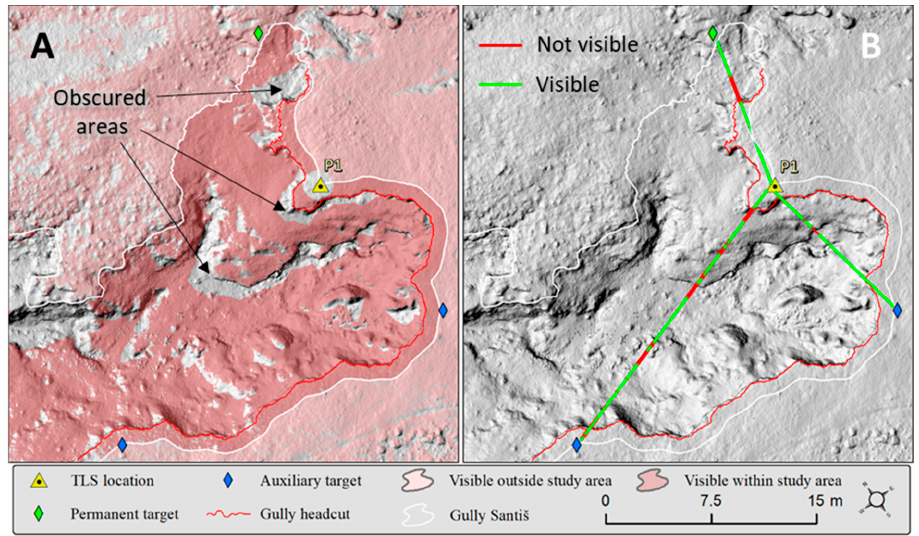
Figure 4. Coverage planned by TPT based on visibility analysis within the rough terrain of gully headcut ( A ); visibility check ( line of sight ) for permanent and auxiliary targets around TLS position 1 ( B ).